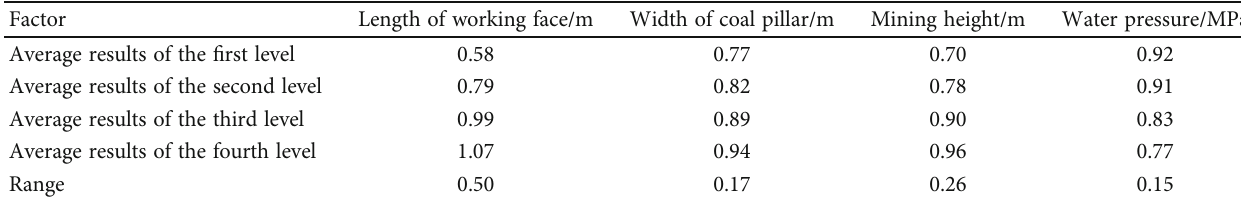
Table 5: Orthogonal experiment range analysis Tab. (maximum vertical